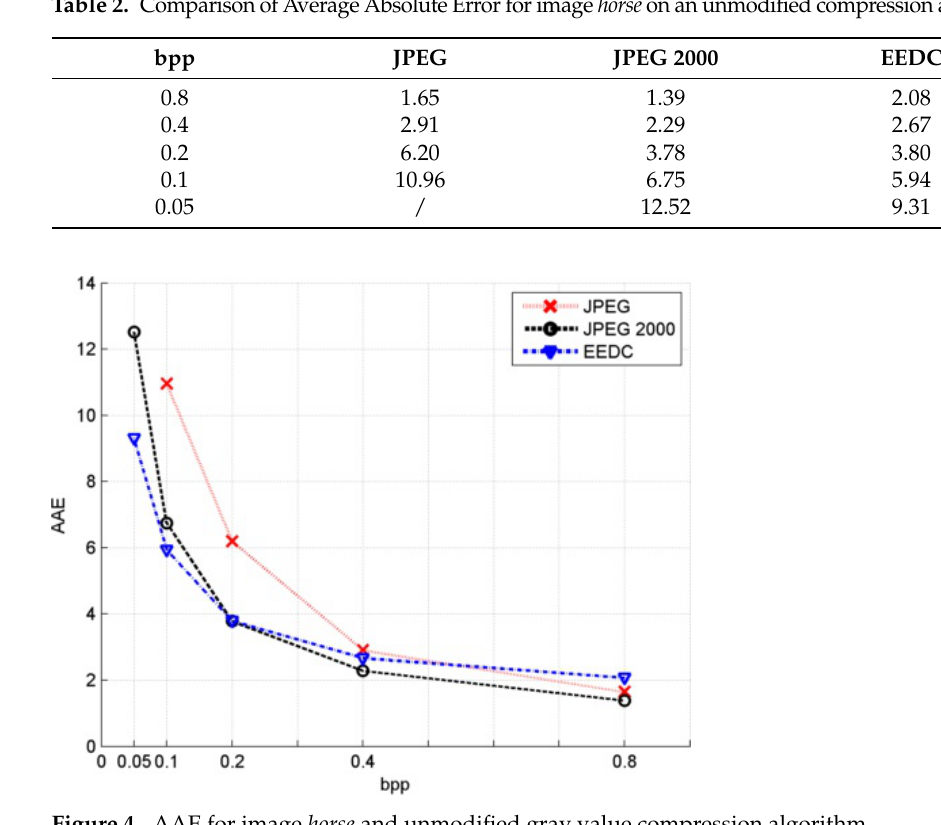
Figure 4. AAE for image horse and unmodified gray value compression